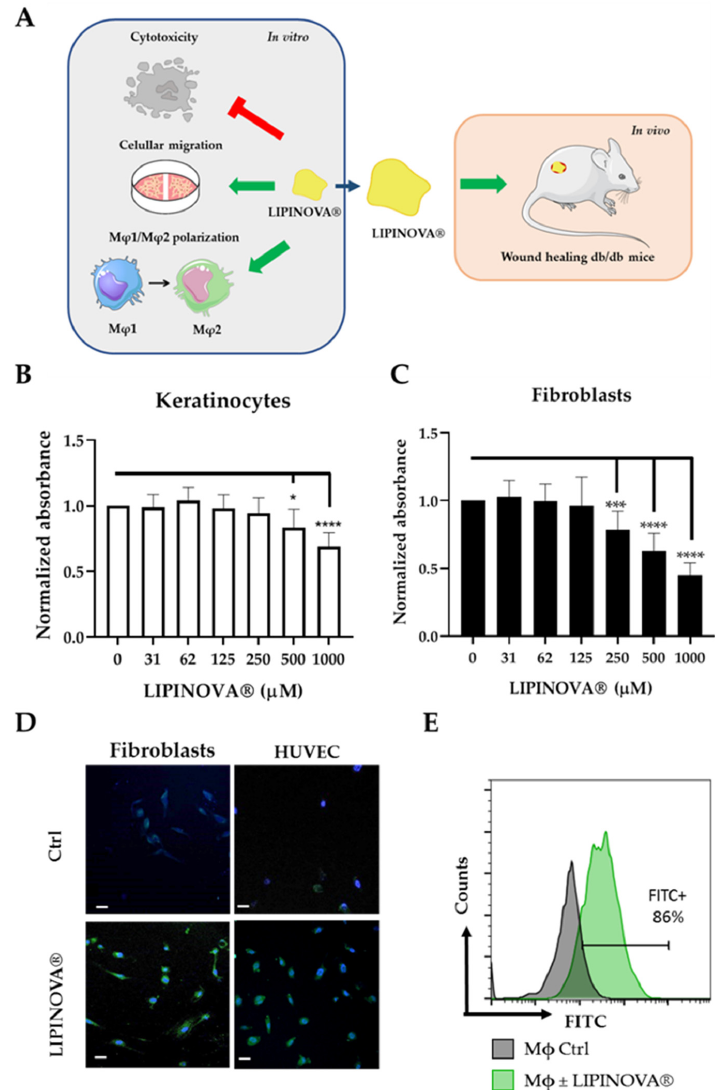
Figure 1. Keratinocyte and fibroblast viability as a function of LIPINOVA ® concentration. ( A ) Sche- matic design of the study. LIPINOVA ® was assessed in vitro for cytotoxicity; uptake by dermal fi- broblasts, endothelial cells, and macrophages; scratch wound healing; and macrophage polariza- tion. Thereafter, the therapeutic potential of LIPINOVA ® was measured in an in vivo wound healing assay in db/db mice. Viability of ( B ) keratinocytes and ( C ) fibroblasts assessed with the CCK-8 assay after incubation with different concentrations of LIPINOVA ® . Absorbance was measured at 450 nm, and data are represented as mean ± SD of three independent experiments. Two-way ANOVA was used for statistical analysis. * p < 0.05, *** p < 0.001, and **** p < 0.0001. ( D ) Immunofluorescence analysis of HUVEC after 6 h incubation with 100 μ M LIPINOVA ® -OG or saline (Ctrl). Cells were fixed and stained with DAPI (blue). Images were acquired with a fluorescence microscope with a 20× objective. Scale bar = 50 μ m. ( E ) Flow cytometry assay to measure LIPINOVA ® internalization in human macrophages.